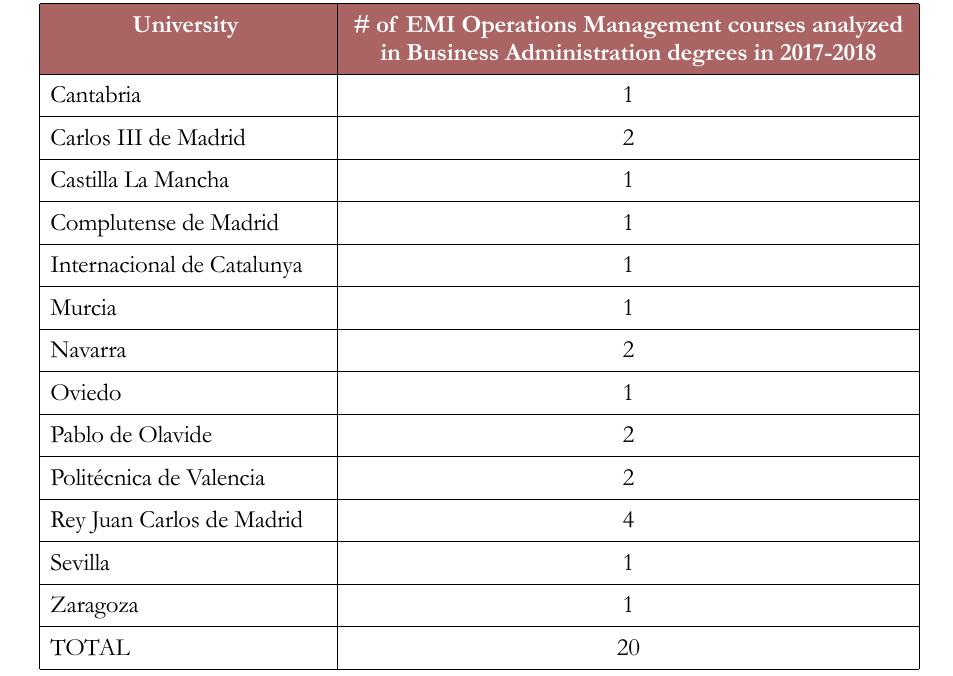
Table 1. Participating universities and number of courses